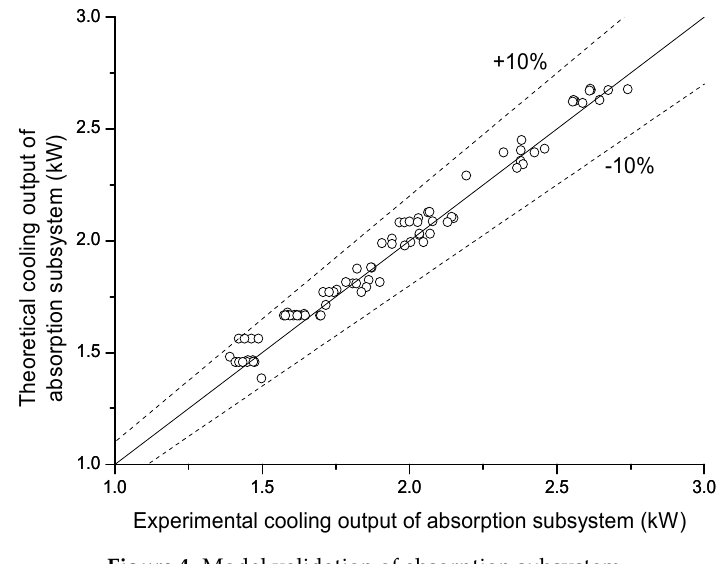
Figure 4. Model validation of absorption subsystem. Table 3. Model Validation of hybrid